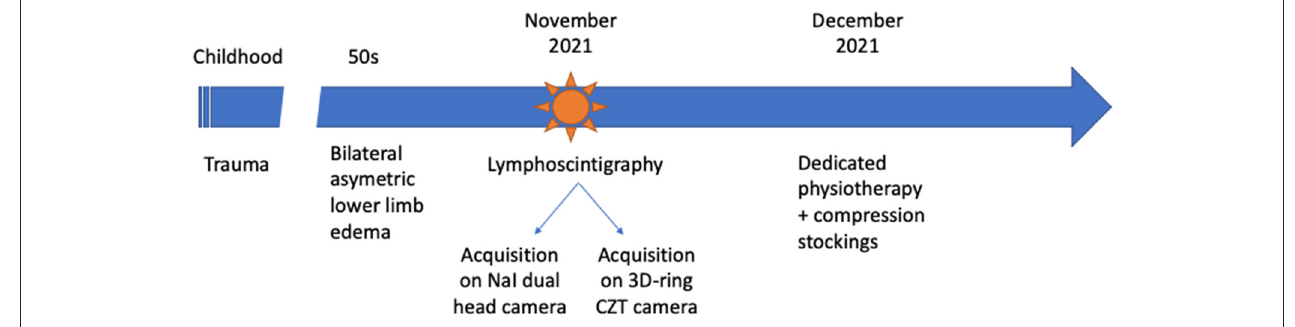
FIGURE 3 | Timeline of diagnosis and intervention for the